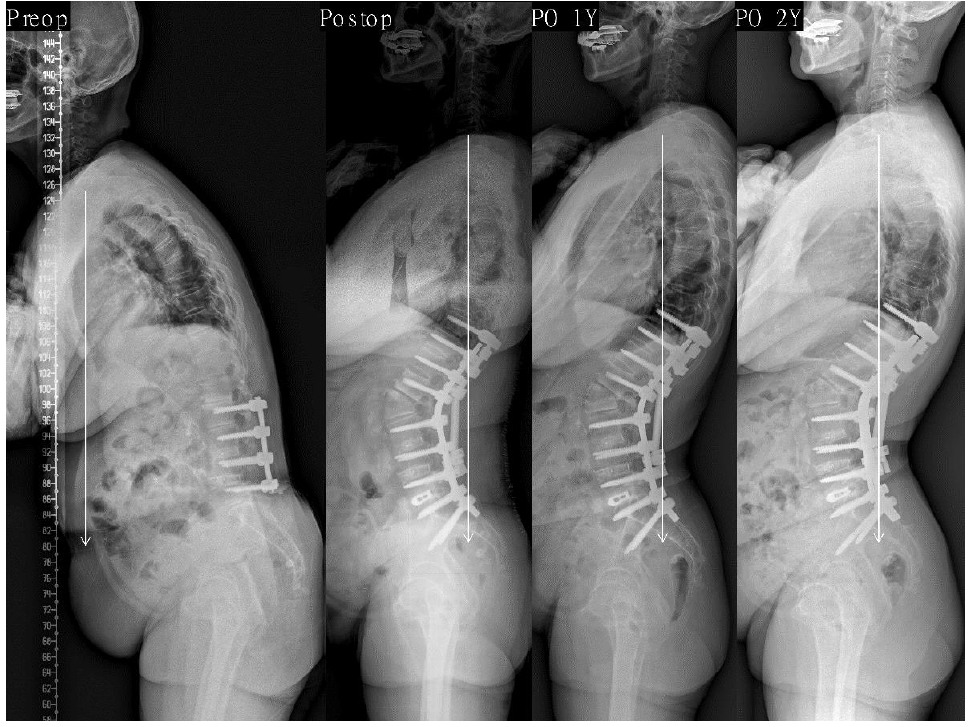
Figure 2. This 68-year-old female presented to us with degenerative sagittal imbalance with PLIF on L2-5 state (SVA + 202 mm, TK 9°, LL 15°, PI 45°, PT 20°, SS 25°). We performed PSO on L2 and PLIF on L5–S1. After surgery, lordosis apex was located at L2 and LDI was 25.0%. PI-LL was −18° (SVA − 16 mm, TK 35°, LL − 63°, PT 7°, SS 38°). Postoperative 1-year whole spine lateral radiograph showing normal sagittal alignment (SVA − 29 mm) and is maintained optimal (SVA − 23 mm) without occurrence of decompensation at the last follow-up period. PLIF indicates posterior lumbar interbody fusion; SVA, sagittal vertical axis; TK, thoracic kyphosis; LL, lumbar lordosis; PI, pelvic incidence; PT, pelvic tilt; SS, sacral slope; PSO, pedicle subtraction osteotomy; LDI, lumbar distribution index.